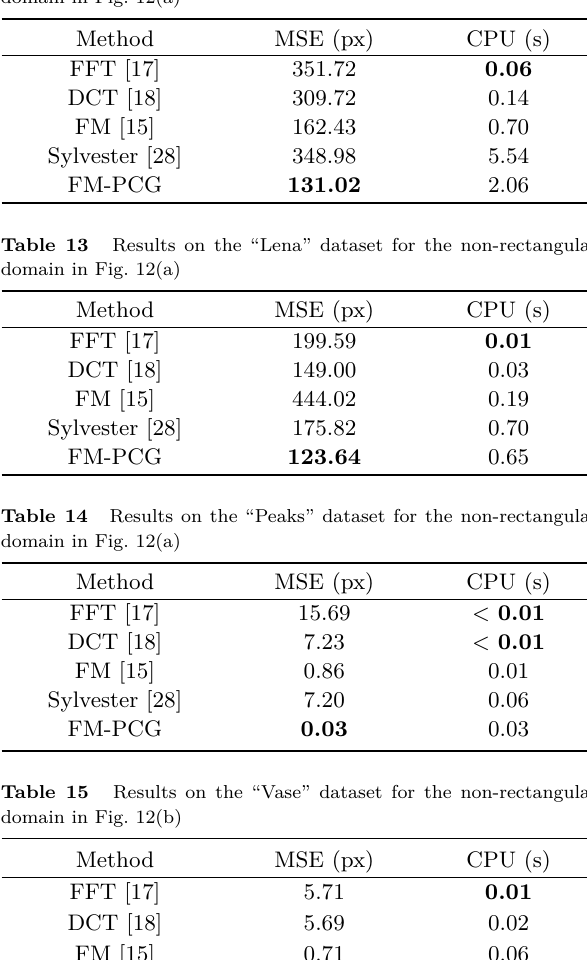
Table 12 Results on the “Phantom” dataset for the non-rectangular domain in Fig. 12(a)